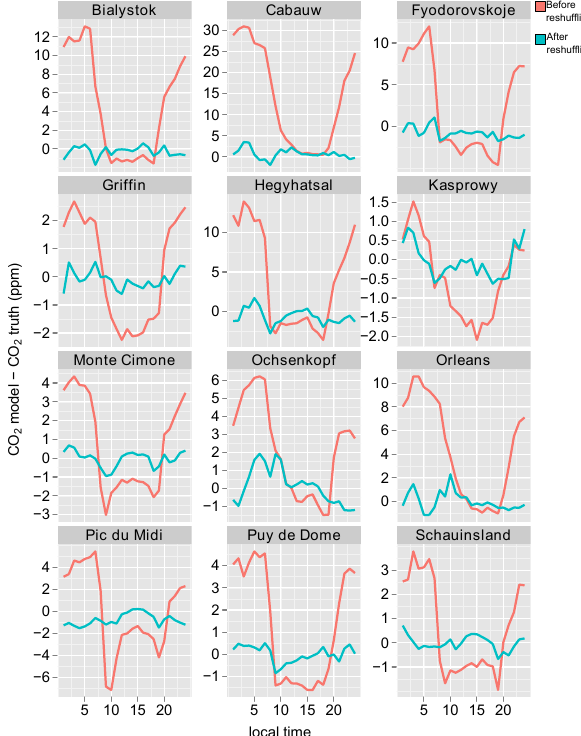
Fig. 9. Same as Fig. 7 but for the bias in ML CO 2 ( < C m , myj − C m , ysu > , red line) and the bias after applying the reshuffling method (Eq. 1) to the MYJ CO 2 fields (cyan